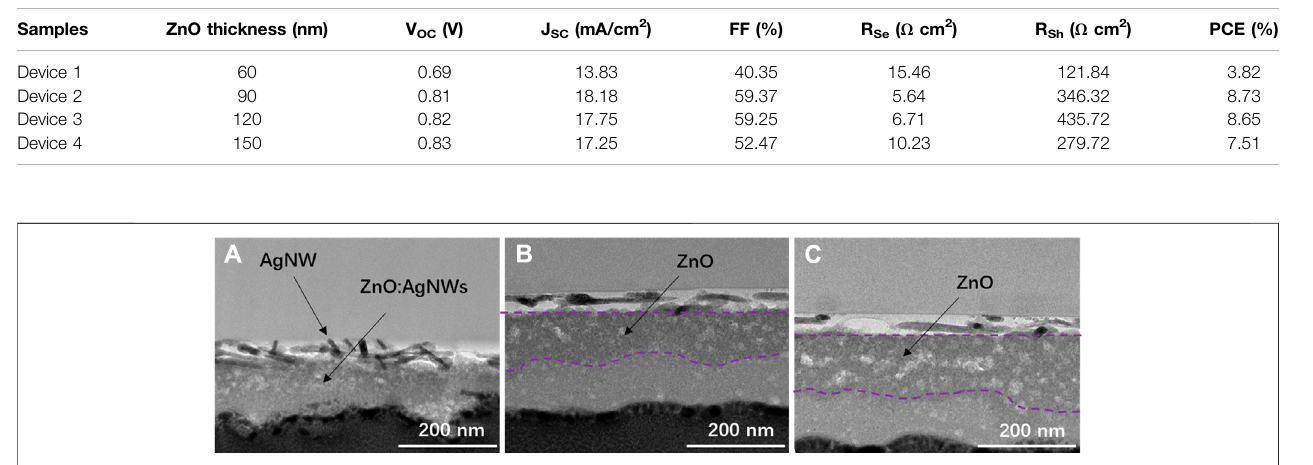
FIGURE 9 | Cross-section investigation of the AgNWs/ZnO fi lms. TEM images of fi lms with (A) 90 nm, (B) 120 nm, and (C) 150-nm-thick ZnO.